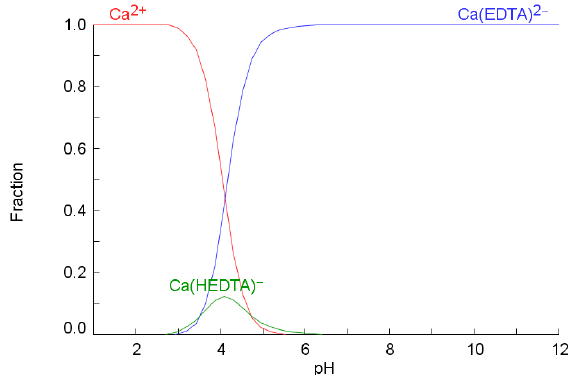
Figure 7. Distribution diagram of calcium species as a function of pH. Drawn using Spana software, Royal Institute of Technology, Sweden.